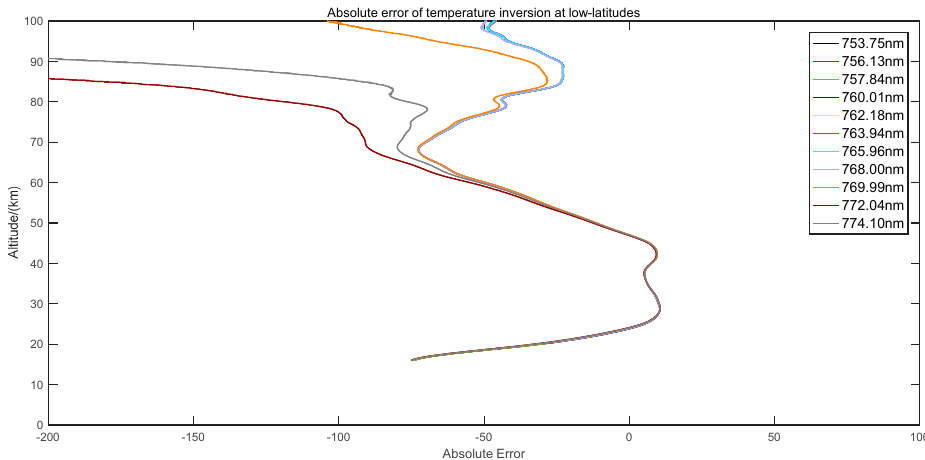
Figure 8. Absolute deviation of temperature inversion results at different wavelengths.